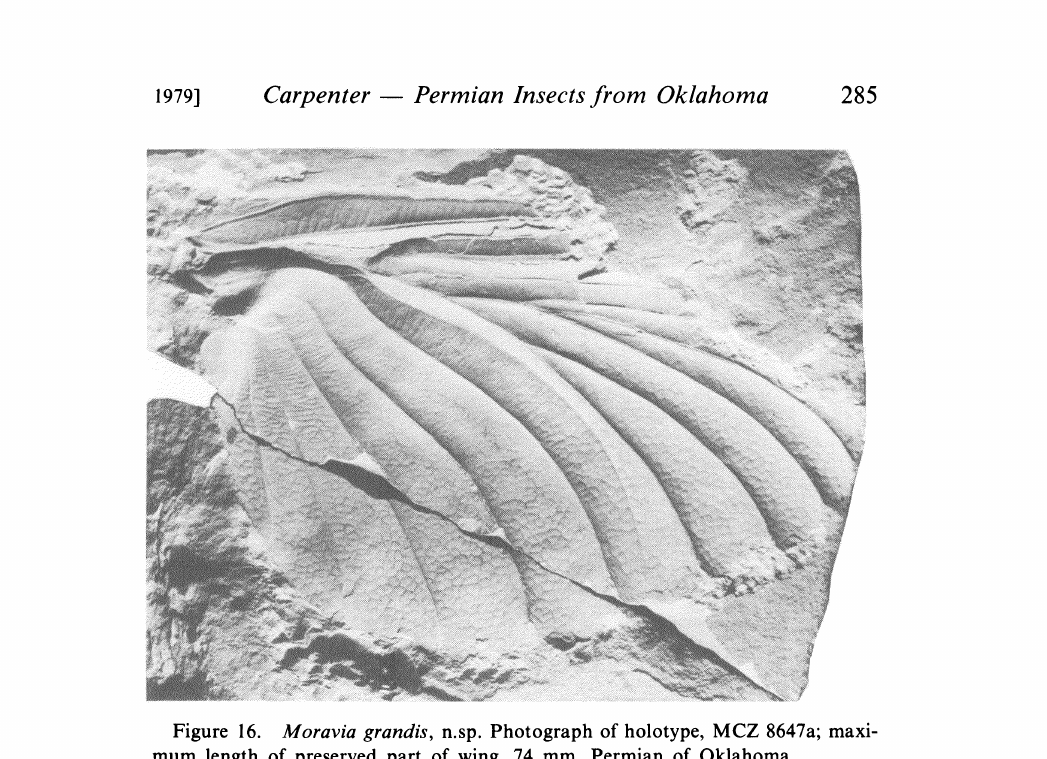
Figure 16. Moravia grandis, n.sp. Photograph of holotype, MCZ 8647a; maxi- mum length of preserved part of wing, 74 mm. Permian of